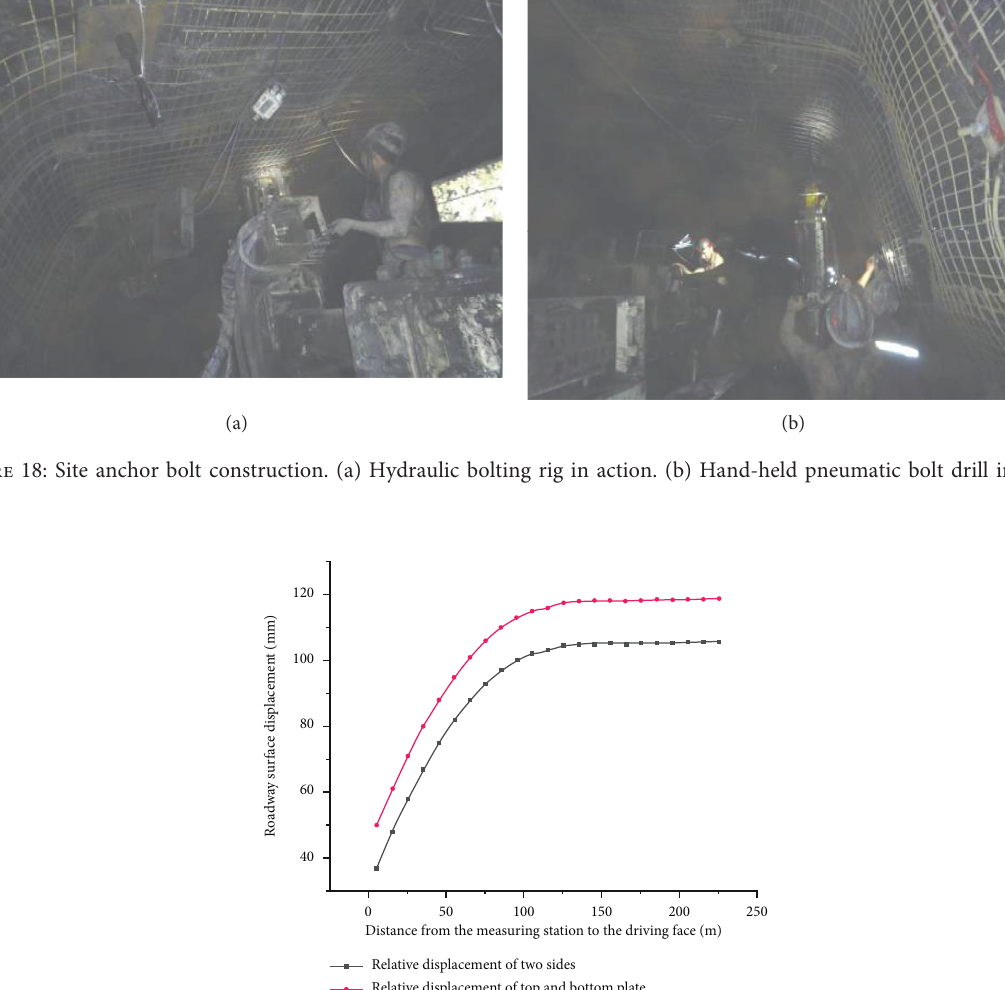
Relative displacement of two sides Relative displacement of top and bottom Figure 19: Convergence deformation curve of the